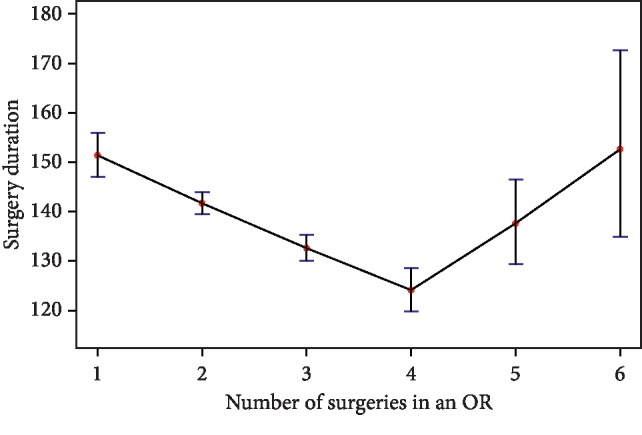
The relationship between the operative duration and the number of surgeries in an OR in a day. When there were no more than four surgeries in an OR, operative duration decreased around 8 minutes if one more surgery was allocated into the OR; when there were more than four surgeries in the OR, operative duration increased around 12 minutes for one more surgery additional surgery into the OR. The confidence intervals of 5 and 6 are much larger than others.